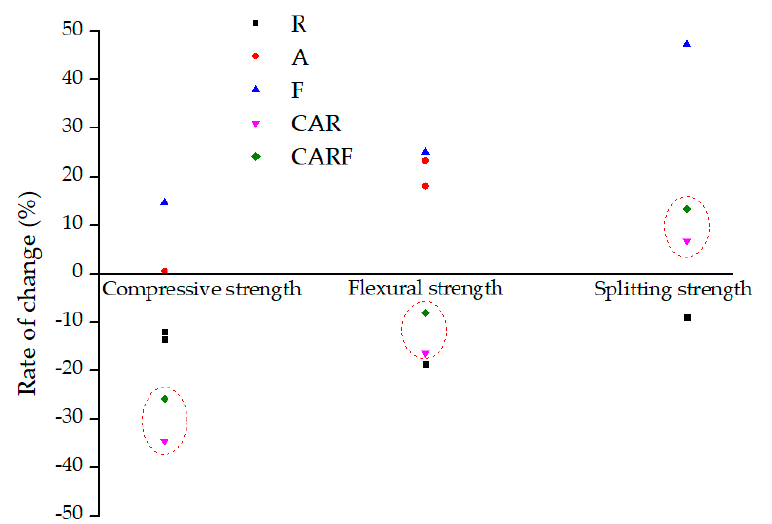
Figure 5. The influence rates of toughening materials on the strength of concrete.